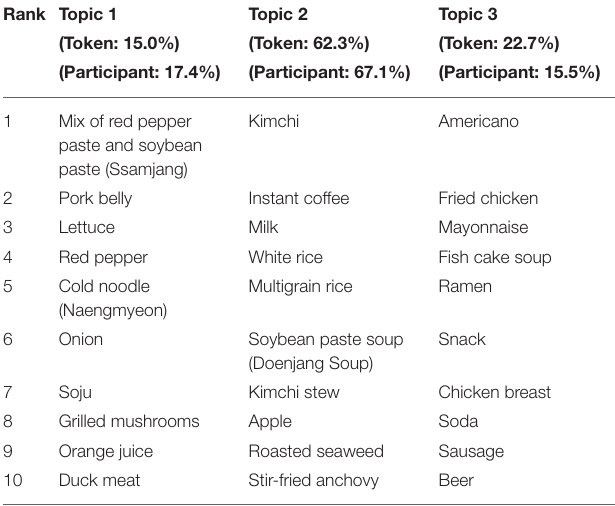
TABLE 3 | Topic-based dietary patterns of